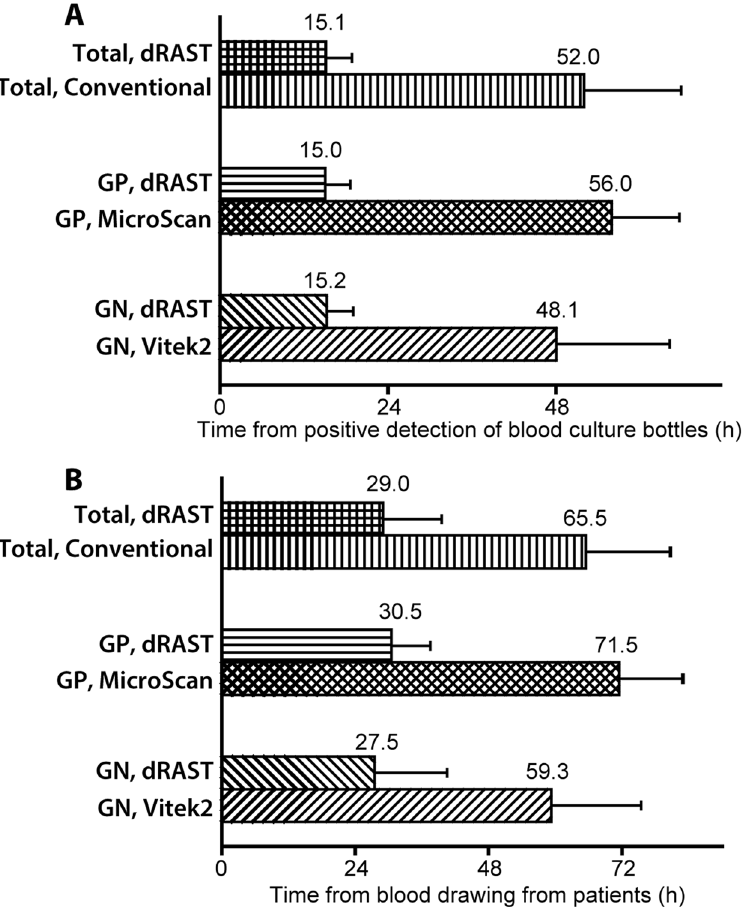
Figure 5. Average time to results of AST from ( A ) time of positive detection of blood culture bottles or ( B ) time of blood collection from patient. The time required for AST using dRAST and a conventional AST method requiring subculture (Vitek 2 or MicroScan) was